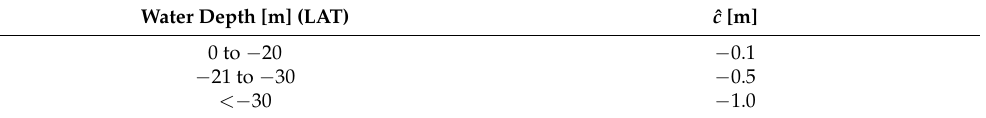
Table 3. Decision thresholds provided as a guide by the NLHS with specific focus on safety of navigation.